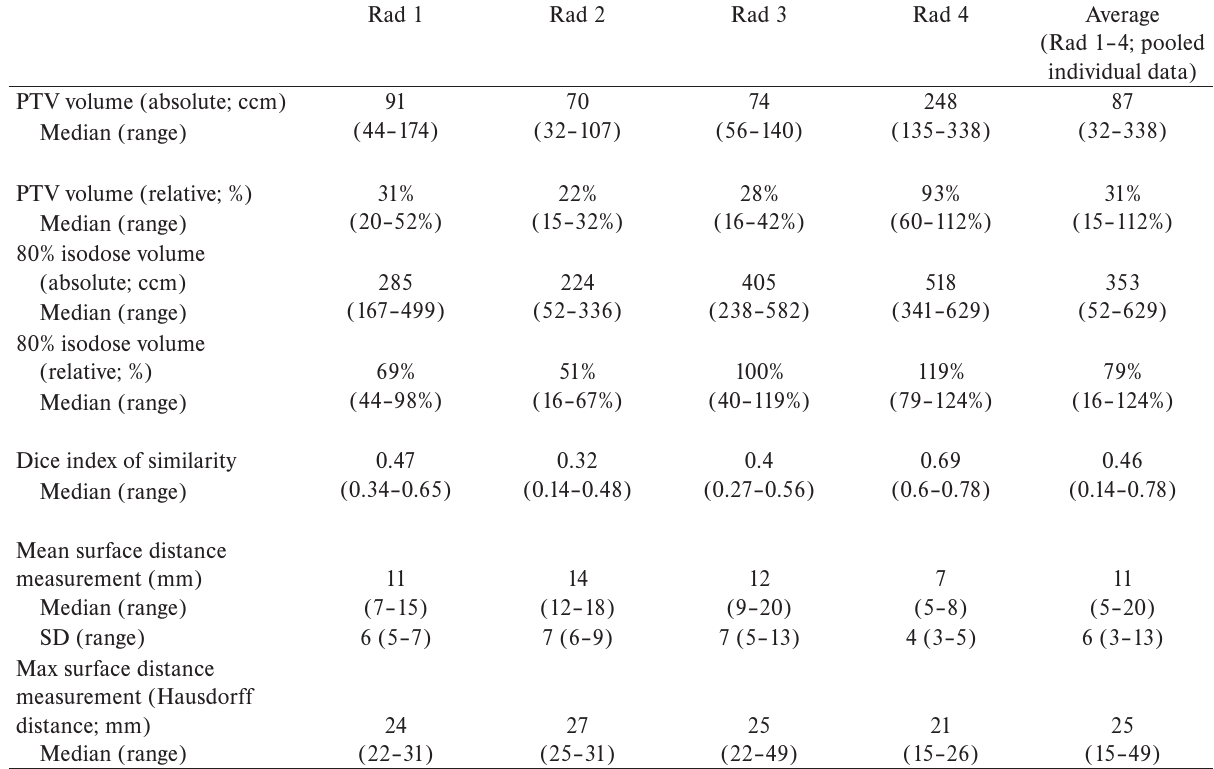
Table 2. Comparison of radiologists’ view of target volume and true volumes used in